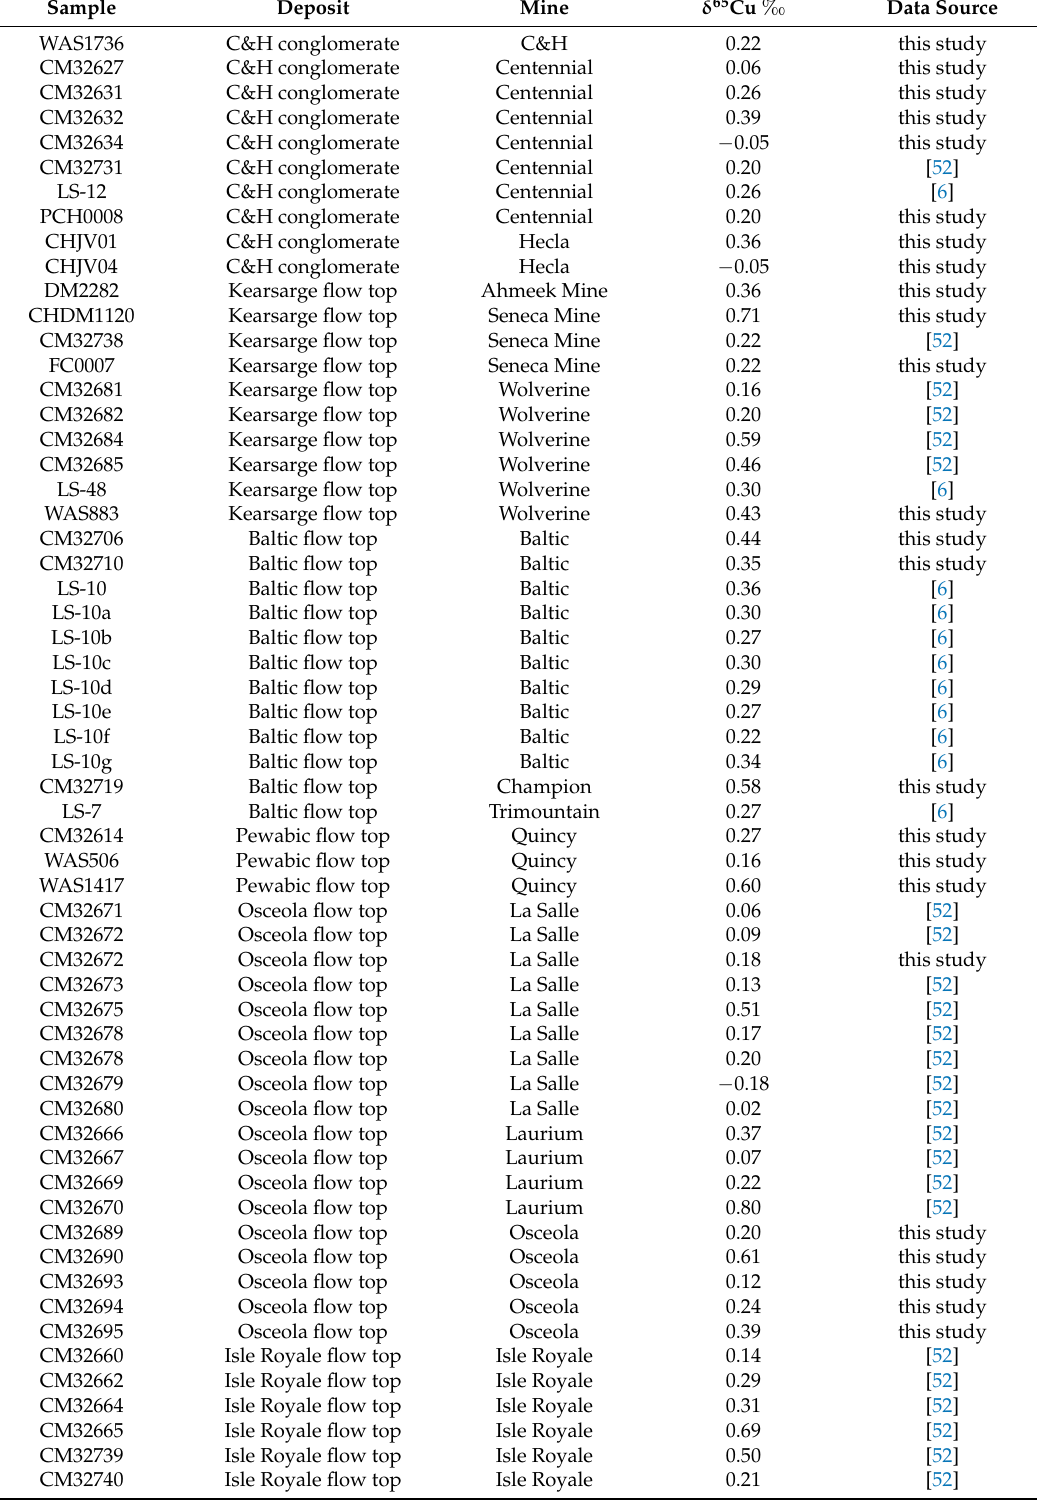
Table 2. Copper isotopic composition of native copper from native copper deposits of the Keweenaw Peninsula, Michigan, USA. The location of the deposits is shown on Figure 2; each deposit is often accessed by multiple shafts which were sometimes operated under different mine names. Copper isotopic composition is the average of two